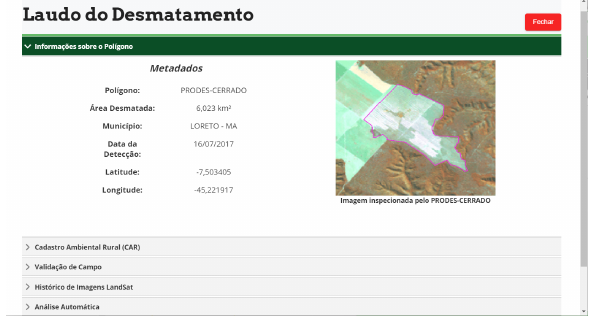
Figure 8. Initial page regarding the Deforestation Report Dialog of a selected polygon.